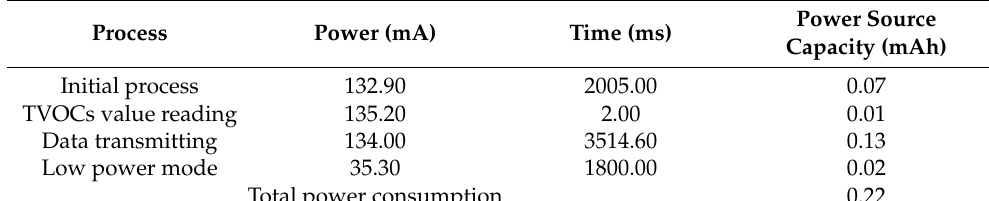
Table 7. Power source capacity.